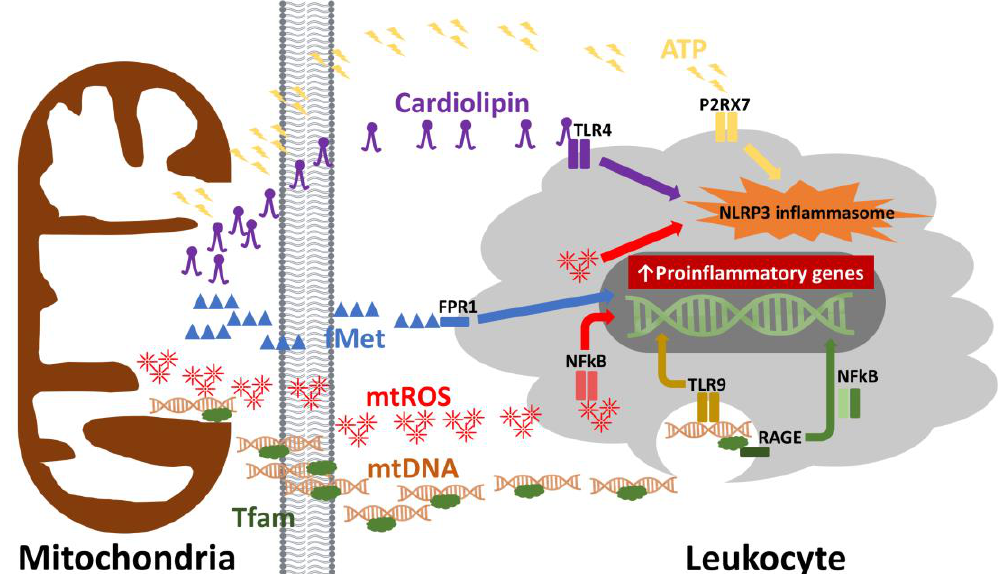
Figure 1. Mitochondrial damage associated molecular patterns (DAMPs). DAMPs derived from mitochondrial components may be released during cellular injury, apoptosis or necrosis. Once these mitochondrial components are released into the extracellular space, they can lead to the activation of innate and adaptive immune cells. The recognition of mitochondrial DAMPs involves toll-like receptors (TLR), formyl peptide receptors (FPR) and purigenic receptors (P2RX7). By binding their cognate ligands or by direct interaction (i.e., reactive oxygen species, ROS), intracellular signaling pathways such as NFkB and the NLRP3 inflammasome become activated resulting in a proinflammatory response. TLR4 = toll-like receptor 4, TLR9 = toll-like receptor 9, P2RX7 = purigenic receptor, FPR1 = formyl peptide receptor 1, NLRP3 = NLR Family Pyrin Domain Containing 3, fMet = N-formylmethionine, mtROS = mitochondrial reactive oxygen species, mtDNA = mitochondrial DNA, Tfam = transcription factor A, mitochondrial, RAGE = receptors for advanced glycation end-products, NFkB = nuclear factor kappa-light-chain-enhancer of activated B